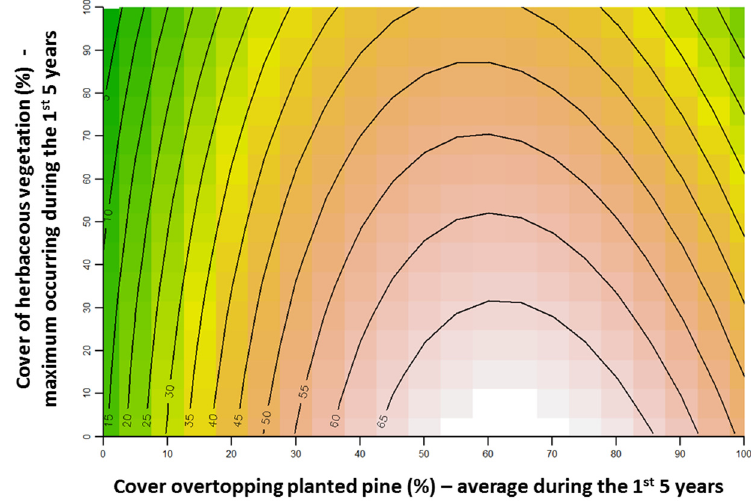
Figure 5. Two-dimensional representation (contour plot) of the response surface for age-10 planted pine P250 (percentage of trees meeting or exceeding an age-10 height target of 250 cm), as a function of maximum herbaceous vegetation cover occurring during the first 5 growing seasons and average overtopping cover during the same period. Herbaceous and overtopping cover are the sum of grass, forb, ferns, and low shrub cover, and deciduous tree, tall shrub, and overstory tree cover, respectively. Colour tones range from highest (white) to lowest (green) P250.